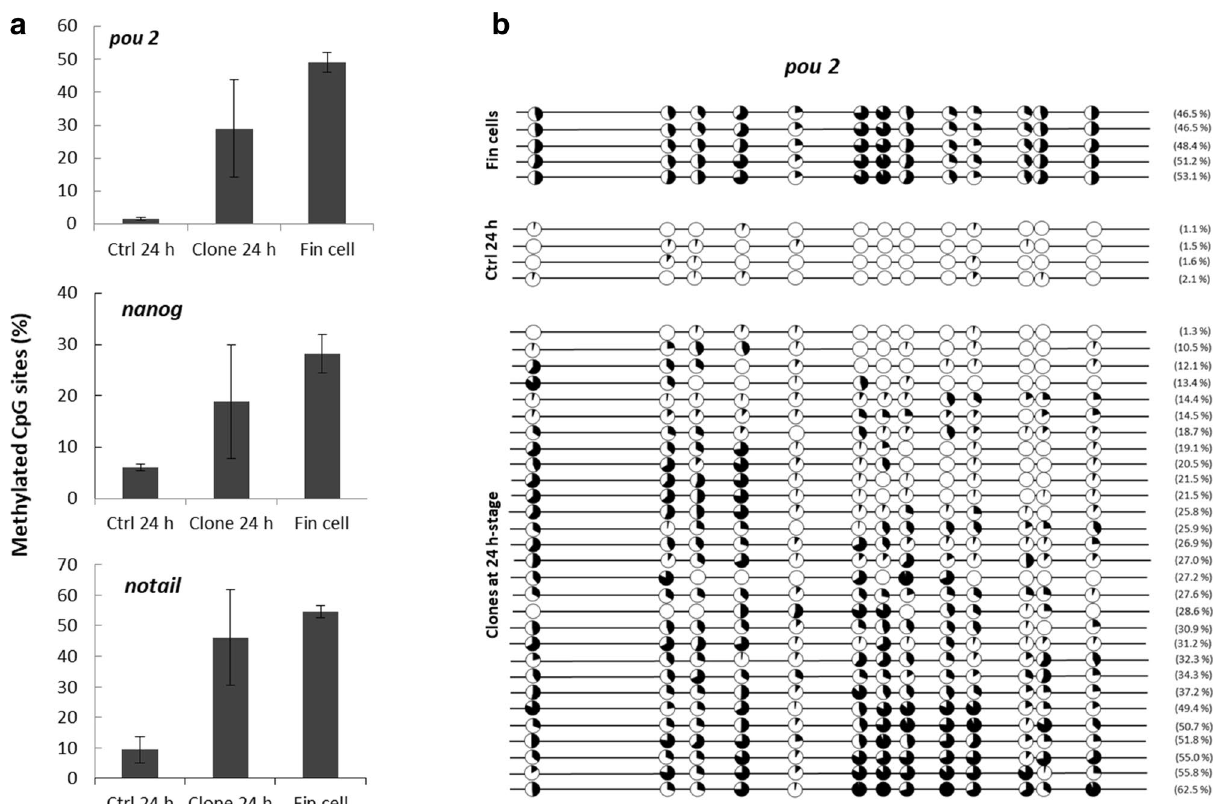
Figure 6. DNA methylation in 24 h-stage clones compared to donor fin cells and control fertilized embryos. ( a ) Mean methylation level of the CpG sites in pou2, nanog and notail promoter regions. Values for methylated CpGs are expressed as a percentage of all CpGs analyzed in a given promoter region. The results are shown as mean values of n replicates; Fertilized embryos (Ctrl): n = 4 pools of 5 embryos; Clones: n = 29 individual embryos; Fin cells: n = 5 cell pools of independent cell cultures. Different letters (a, b, c) indicate significant differences (p < 0.05). ( b ) Individual CpG methylation levels in pou 2 promoter region. Each circle represents a CpG site. Black content: DNA methylation percentage. Values between brackets are the mean DNA methylation of all CpG sites in a given